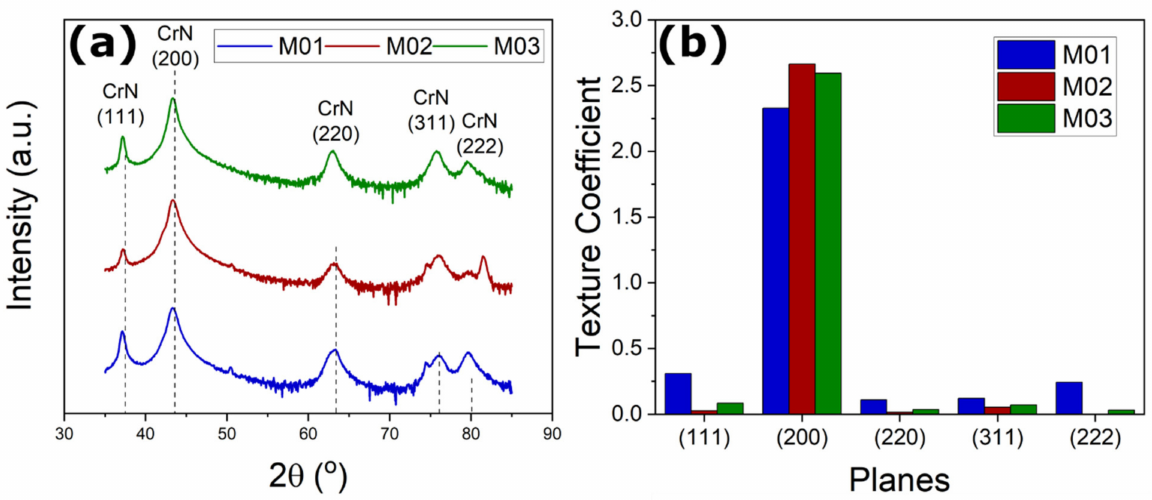
Figure 2. The diffractograms ( a ) of the multilayers deposited under the M01, M02, and M03 ex- perimental conditions showing the presence of CrN peaks and satellite peaks and ( b ) the texture coefficient